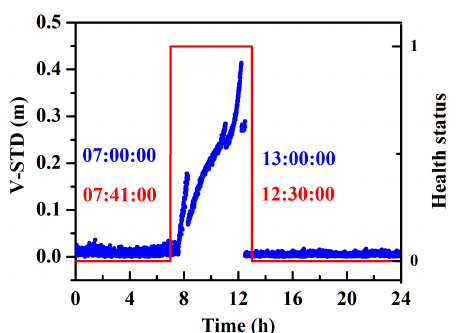
Figure 13. Comparison between the marked time of orbital maneuver by the broadcast ephemeris and real-time detection approach (health status: “0” represents healthy, and “1” represents unhealthy).